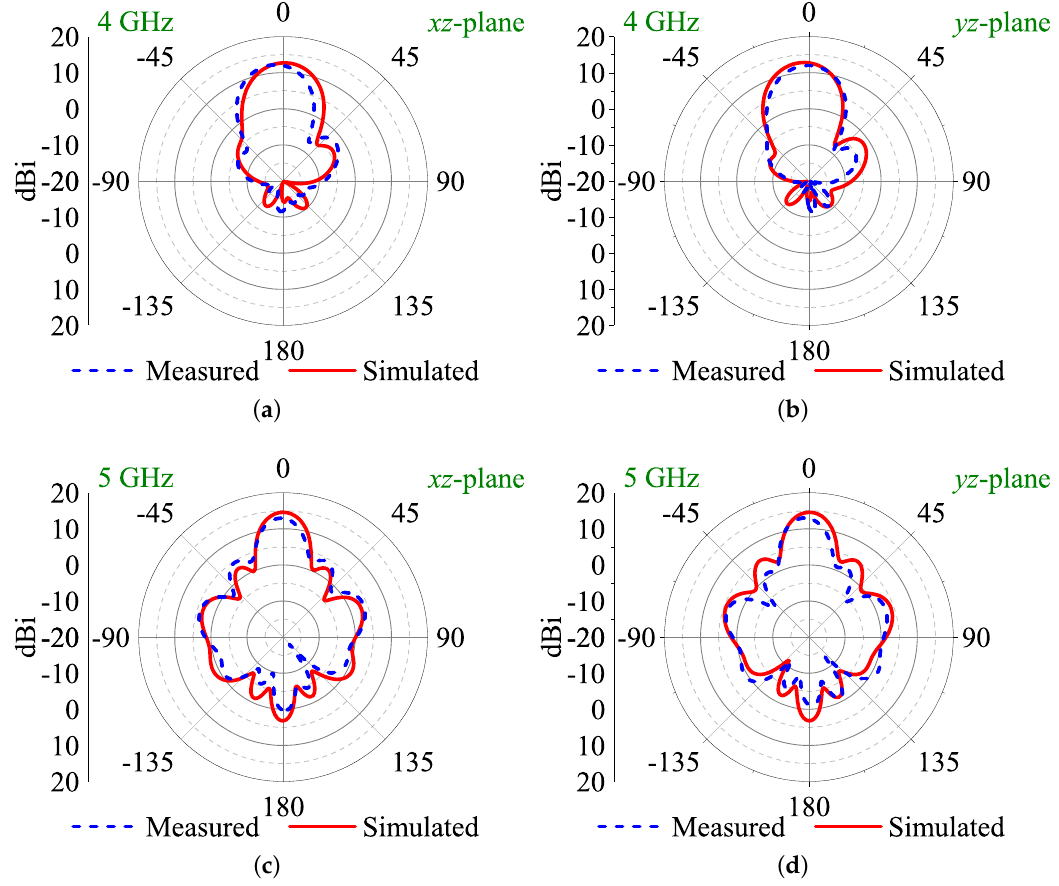
Figure 9. Simulated and measured radiation patterns at ( a ) 4 GHz along xz -plane, ( b ) 4 GHz along yz -plane, ( c ) 5 GHz along xz -plane and ( d ) 5 GHz along yz